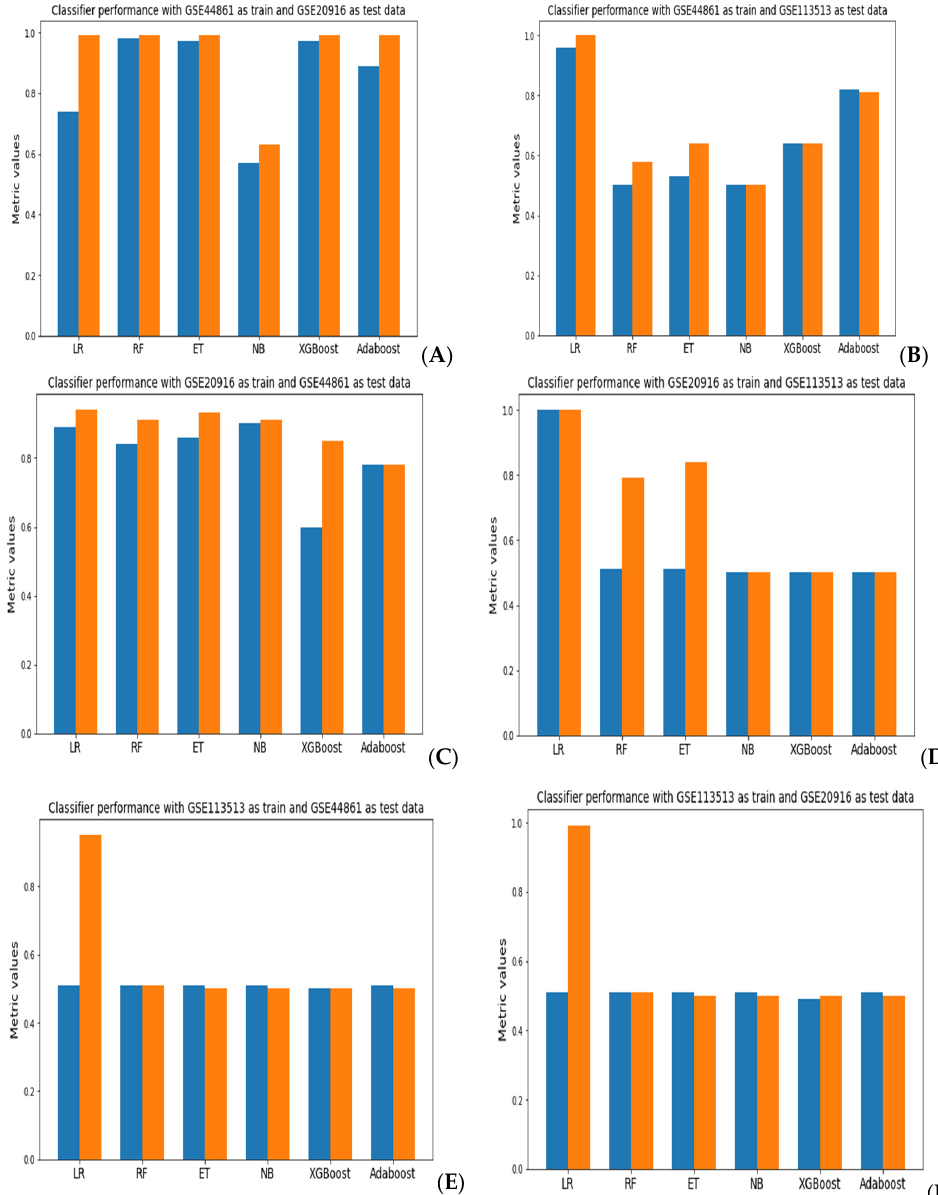
Figure 2. A comparison of accuracy (blue) and AUROC (orange) values obtained across the different classifiers using combinations of the GEO datasets as training and test datasets. ( A ) GSE44861 (training) and GSE20916 (test); ( B ) GSE44861 (training) and GSE20916 (test); ( C ) GSE20916 (training) and GSE44861 (test); ( D ) GSE20916 (training) and GSE113513 (test); ( E ) GSE113513 (training) and GSE44861 (test); ( F ) GSE113513 (training) and GSE20916 (test).